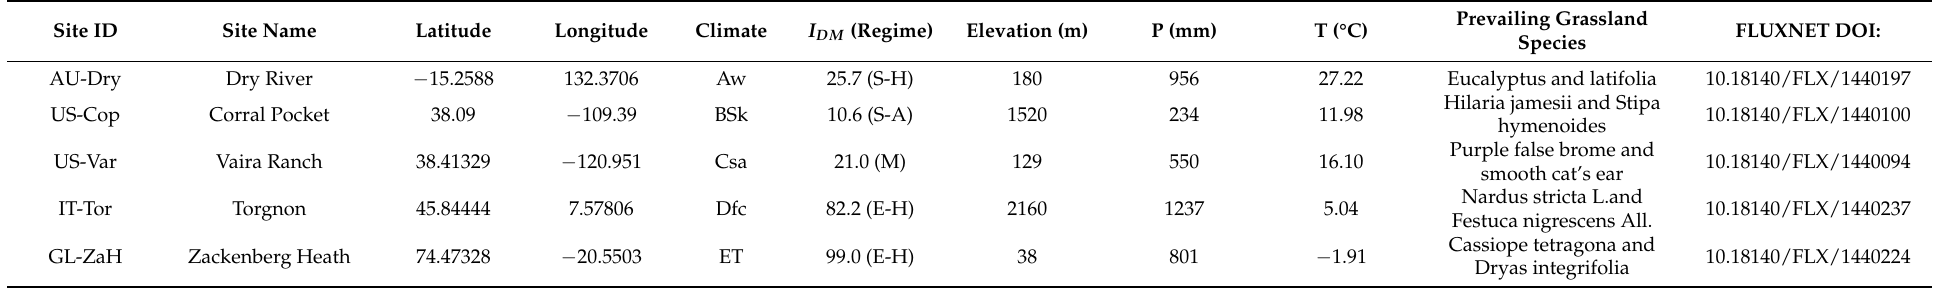
Table 1. The five sites with their main characteristics. S-H stands for Semi-Humid, S-A stands for Semi-Arid, M stands for Mediterranean, E-H stands for Extremely-Humid. P and T values refer to their annual